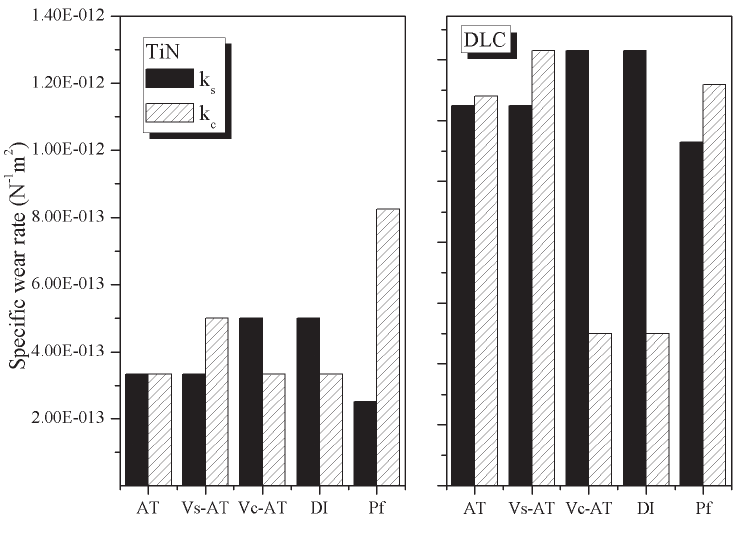
Figure 11. Evaluation of specific wear rates of substrate and coating, ks and kc, using four equations of data analyses methods (AT, Vs-AT, Vc-At and DI by conventional micrsocopy) compared with specific wear rates of ks and kc from the data obtained using profilometry (pf) technique.